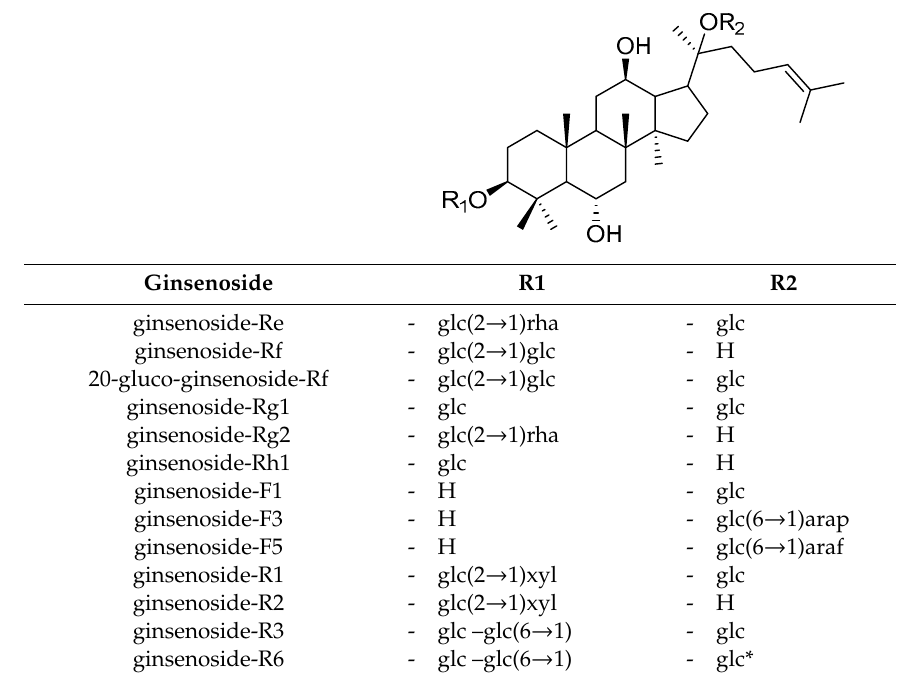
Table 3. Chemical structures of protopanaxatriol type saponins.